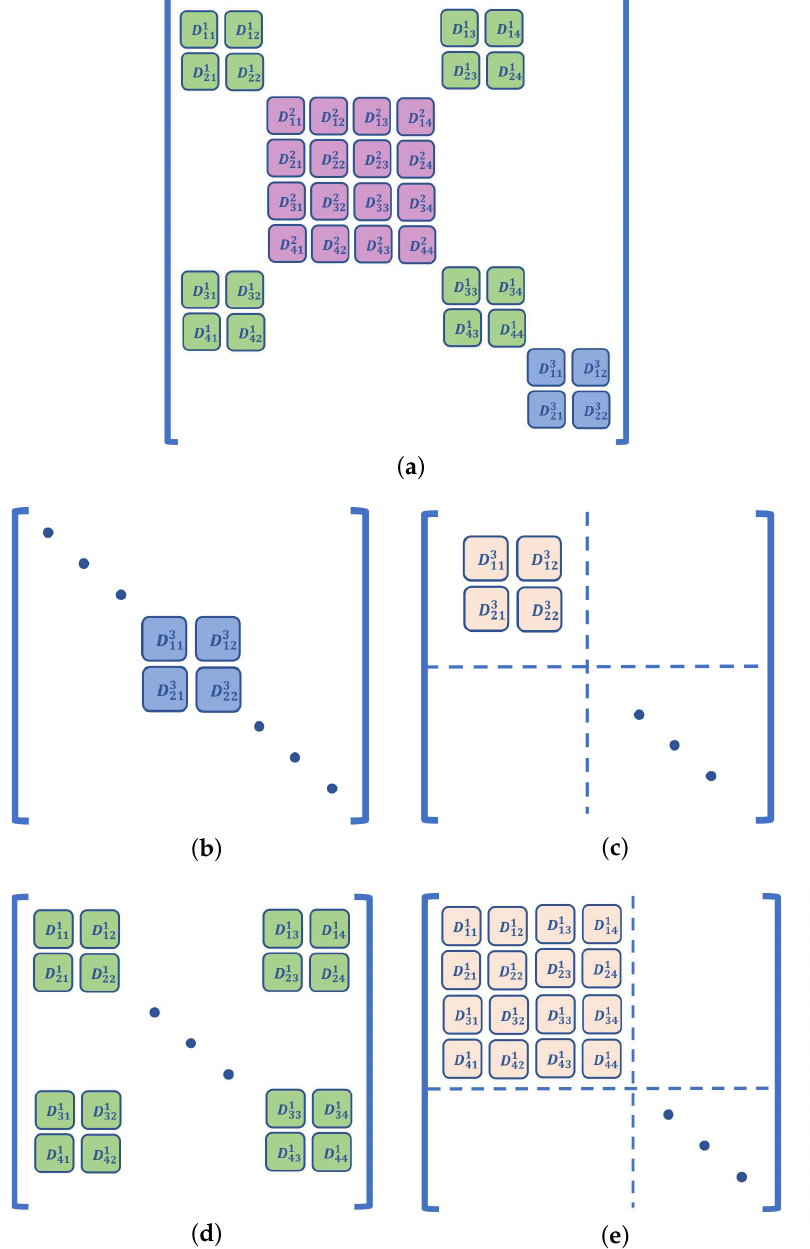
Figure 1. A simple example of Hessian matrix J . Graph ( a ) shows the arrangement of elements in one of the cooperative scenarios. Graph ( b ) represents Q i associated with the target T i , and ( c ) represents Q (cid:48) i , which is the matrix after the row and column transformation of Q i . Similarly, Graphs ( d , e ) represent Q i and Q (cid:48) i associated with target-target (TT) links in the cooperative